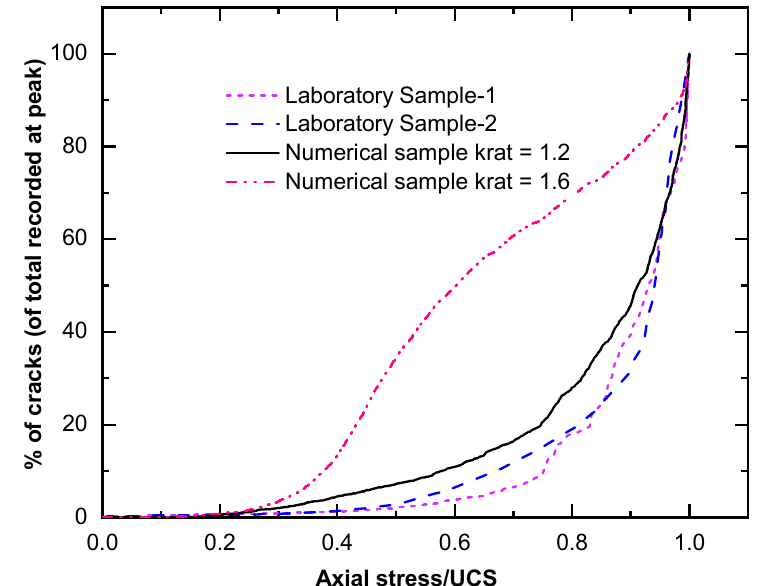
Figure 6. Comparison of microcrack formation in the numerical sample with krat = 1.6 or 1.2 and the laboratory Lac du Bonnet granite sample. The sample-1 result is from Martin [29] and the sample-2 result is from Eberhardt et al. [30]. Note the numerical samples with krat = 1.6 or 1.2 are calibrated by the same macroparameters as those for Lac du Bonnet granite.